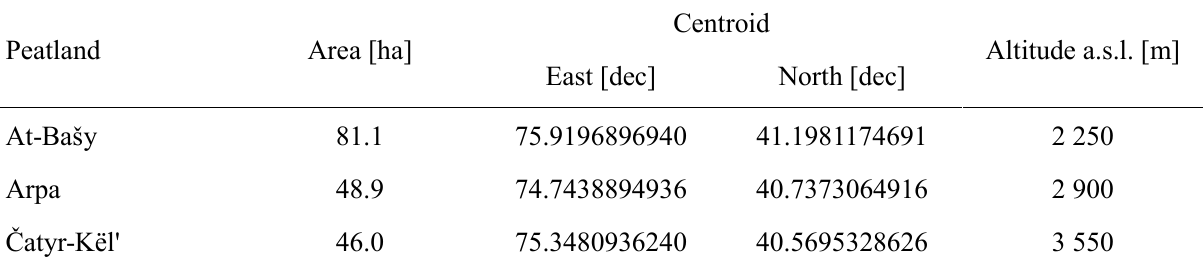
Figure 1. Location of the investigated peatlands in Kyrgyzstan. (coordinate reference system: EPSG:4326, Map data: © OpenStreetMap contributors, CC-BY-SA 2.0). Table 1. Geographical location (coordinate reference system: EPSG:4326) and area of the